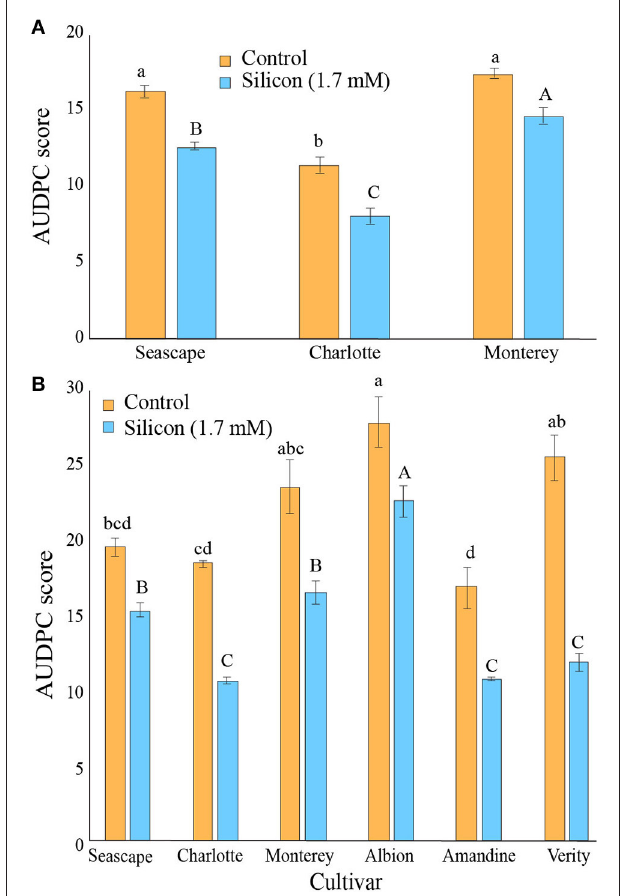
FIGURE 5 | Area Under Disease Progress Curves for Podosphaera aphanis on strawberry leaves of plants treated or not with 1.7 mM Si in a high tunnel commercial setting during summer 2014 (A) and summer 2015 (B) . Each value represents the mean ± SE ( n = 4). Multiple comparison test (Tukey HSD) has been done on each treatment independently. Means with different letters are significantly different.